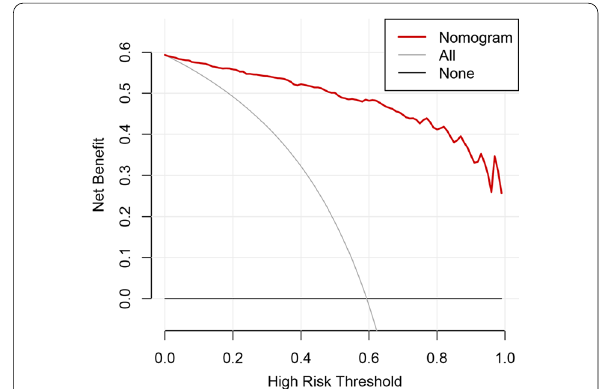
Fig. 4 Decision curve analysis for this model in predicting MPE for patients with lung adenocarcinoma. The y-axis measures the net benefit. The grey line represents the assumption that all lesions were malignant (the treat-all scheme). The black line represents the assumption that all lesions were benign (the treat-none scheme). If the threshold probability was more than 5%, using the nomogram to predict malignancy added more benefit than either the treat-all scheme or the treat-none scheme (red